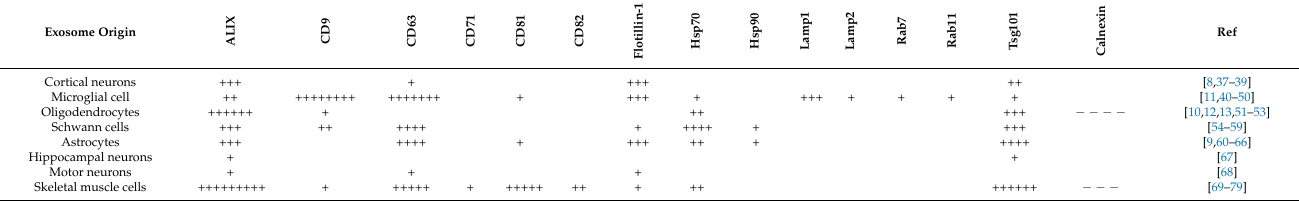
Non-exhaustive list of different cell types secreting exosomes including neuronal cells (cortical neurons and neuroglial cells) and skeletal muscle cells. The classic exosome markers used to identify and characterize isolated vesicles (ALIX, CD9, CD63, CD81, Flotillin, Hsp70 and Tsg101) are shown. Each “+” or “ − ” sign represents a paper reporting sEVs harbouring typical exosomes markers (“+”) or absence of the endoplasmic reticulum marker, calnexin (“ −